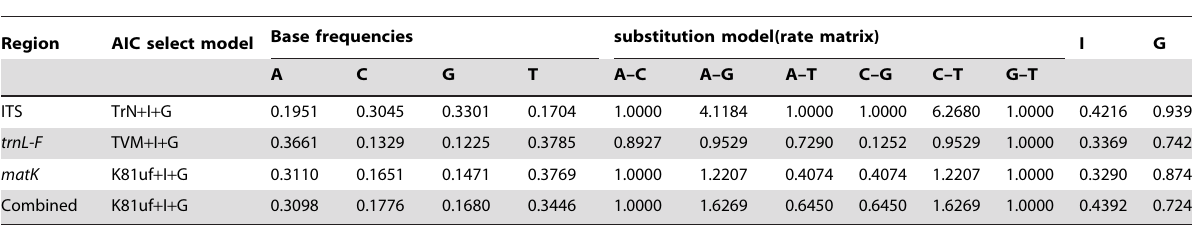
Table 2. Best-fit model and parameter for each dataset.